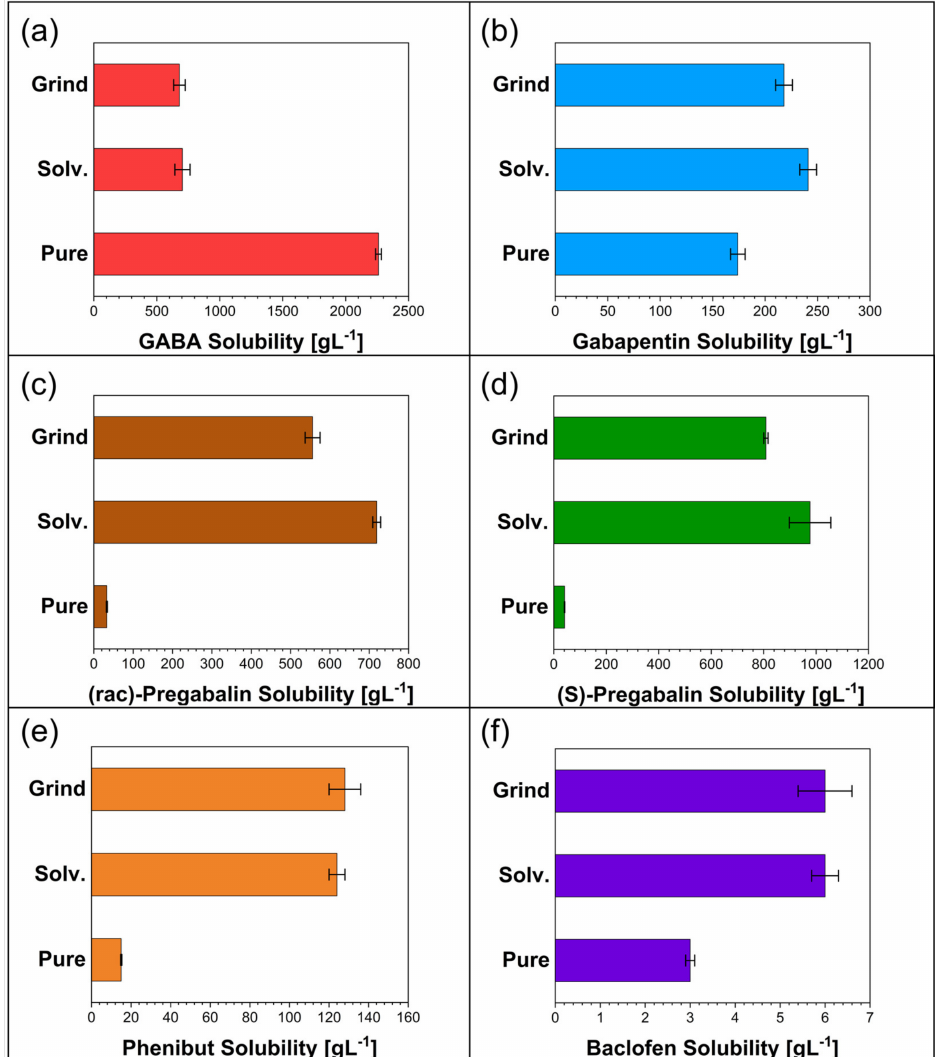
Figure 12. Recorded solubilities of the investigated samples in gL-1 regarding their API solubility of ( a ) 1 , ( b ) 2 , ( c ) ( rac )-3 , ( d ) ( S )-3 , ( e ) 4 , and ( f ) 5 -based compounds. Solubilities were determined by preparation of saturated dispersions of target compounds in an aqueous solution at 25 ◦ C after three days through 1 H-NMR spectroscopy against the water